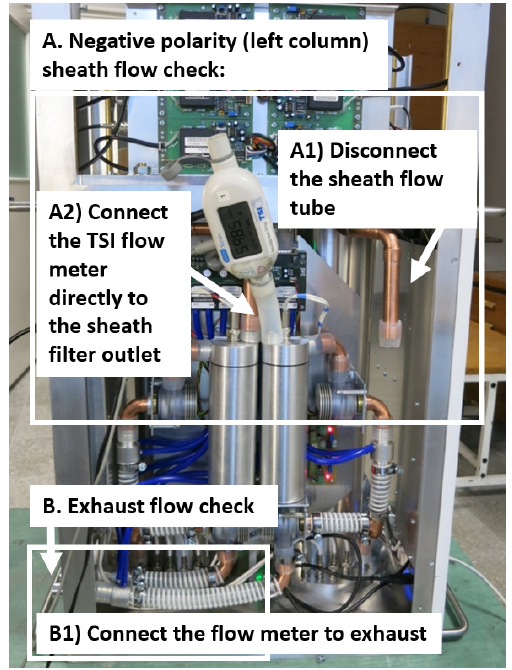
Figure 6. A quick and easy sheath flow check for 4-blower system using a TSI flowmeter which is placed directly after the sheath air